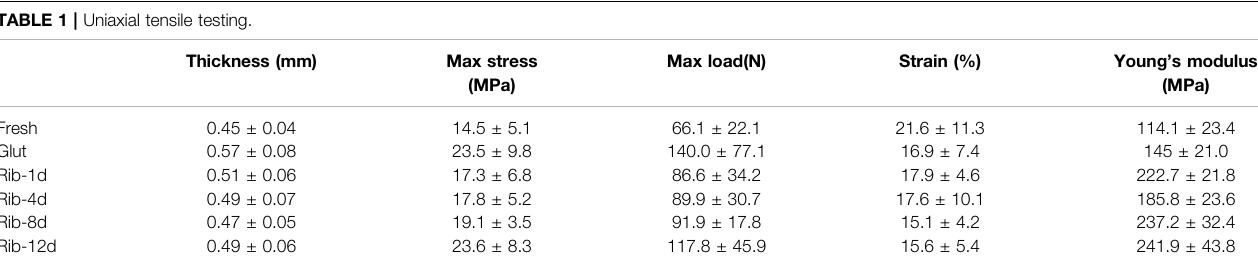
TABLE 1 | Uniaxial tensile